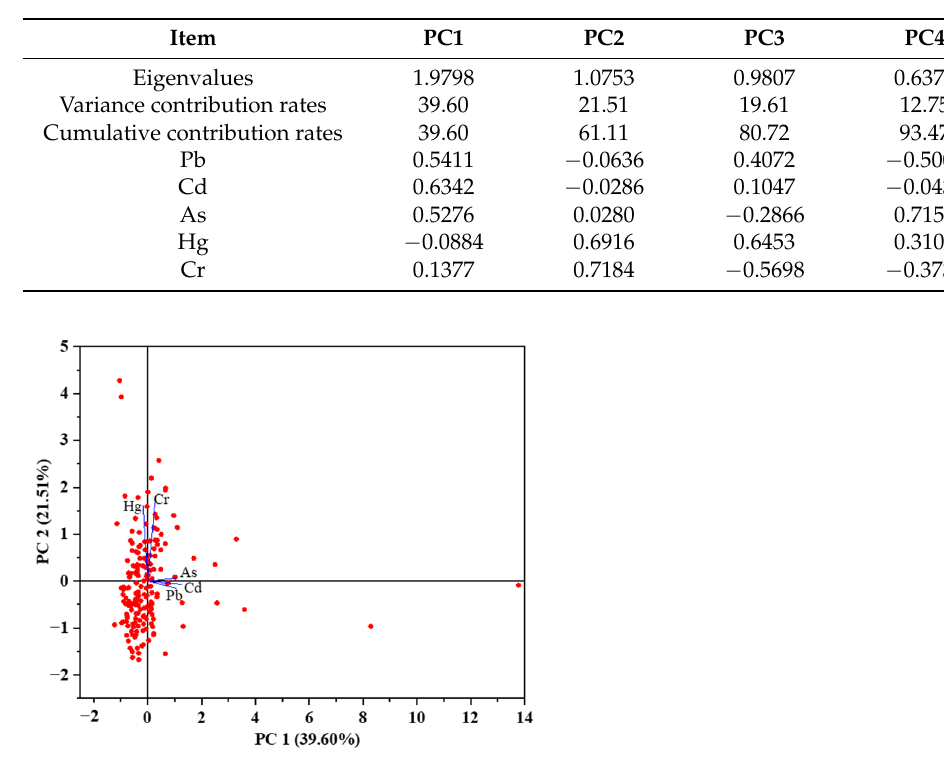
Table 6. Eigenvalues, variance contribution rates, cumulative contribution rates, and component matrix of the principal components of heavy metals.